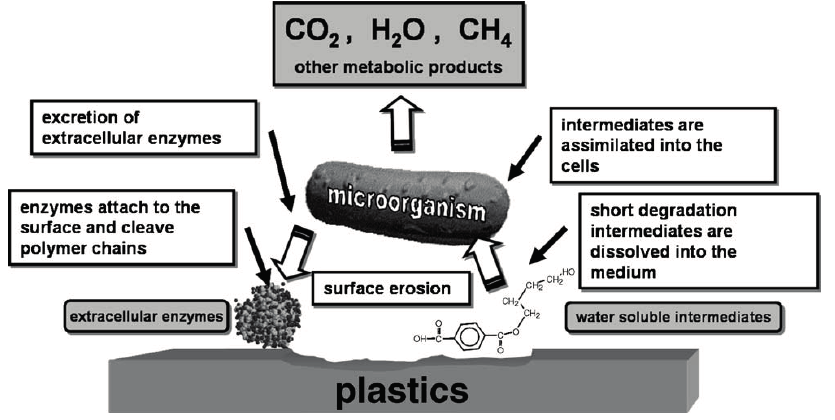
Figure 3. Scheme of general mechanism of enzymatic catalysed hydrolytic polymer degradation, originally published in